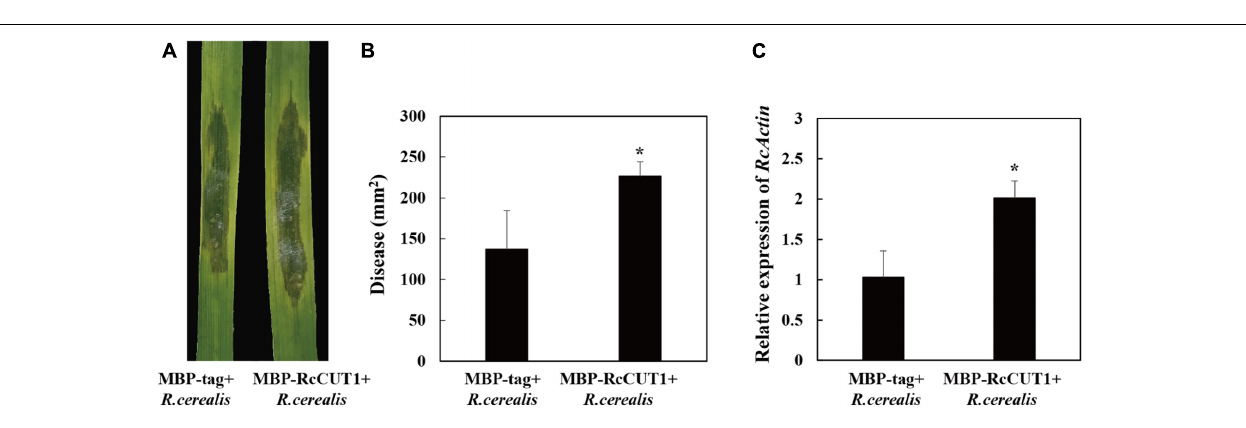
FIGURE 8 | RcCUT1 contributes to pathogenicity in Rhizoctonia cerealis infection to wheat. (A) MBP-RcCUT1 enhanced pathogenic phenotypes of R. cerealis in wheat leaves. Pictures of the lesions were taken at 3 days post-inoculation with the fungus and the lesion area was measured. (B) Disease severity measured as area of necrosis induced by R. cerealis mycelia on leaves shown in A . (C) RT-qPCR measurement of the pathogen and wheat RNA ratios was used to determine R. cerealis relative biomass in infected plant tissues shown in A . Three independent biological replicates were conducted. Error bars were calculated based on three replicates. Asterisk ∗ indicates significant difference between MBP-RcCUT1 treatment and MBP-tag treatment ( t -test; P <